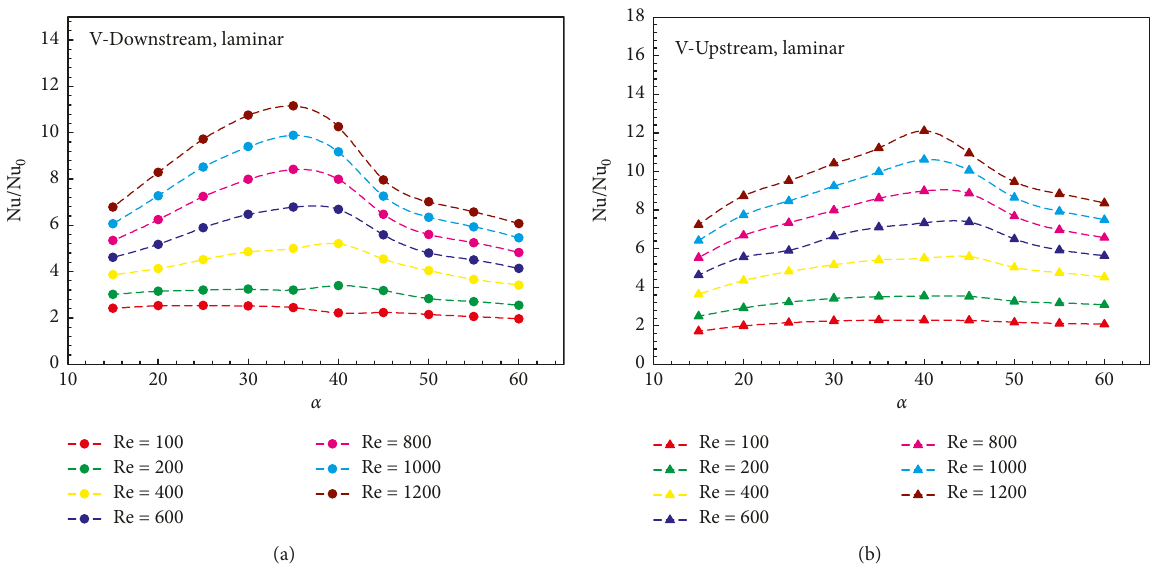
Figure 12: Relations of Nu/Nu 0 with α for the heat exchanger tube inserted with the V-wavy surface for (a) V-Downstream and (b) V- Upstream at the laminar